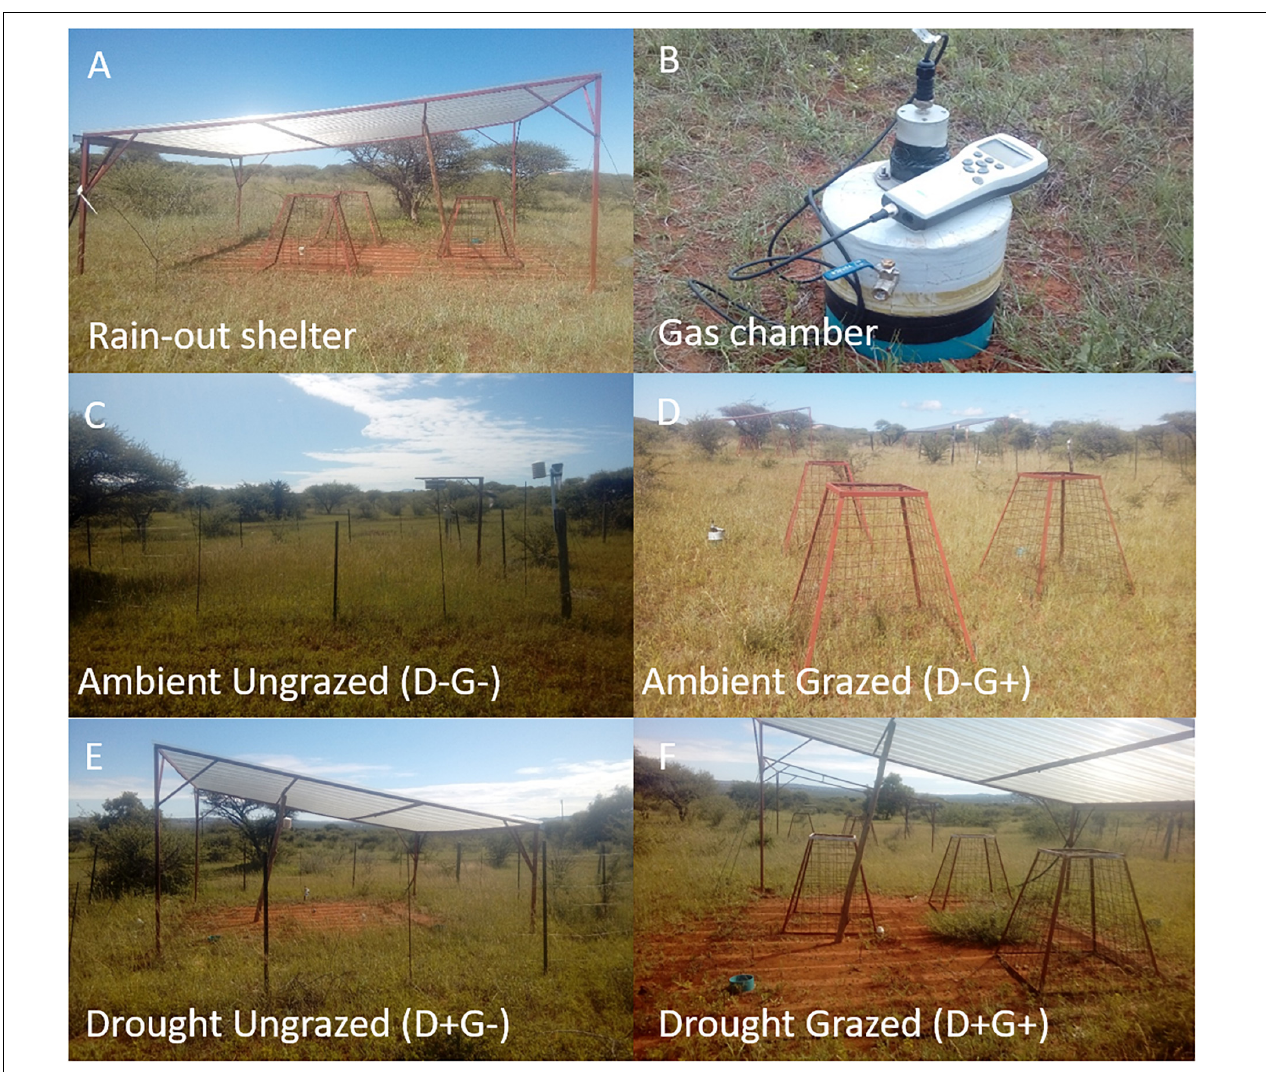
FIGURE 2 | The experimental platform DroughtAct for studying grassland ecosystem responses to combined effects of extreme drought and grazing. (A) Details of a rainout shelter (36 m 2 ) used in DroughtAct to simultaneously study drought and grazing effects; (B) details of a flux chamber used to measure CO 2 release. (C–F) Effects of drought and grazing treatments on grassland vegetation. Pictures were taken in the sixth treatment year during the time of peak standing biomass (February 2020). (C) Ambient rainfall with grazing exclusion (D–G–); (D) ambient rainfall under grazed conditions; the moveable cages are used to assess ANPP without grazing offtake (D – G+); (E) drought with grazing exclusion (D + G–); (F) : drought with moderate grazing (D + G